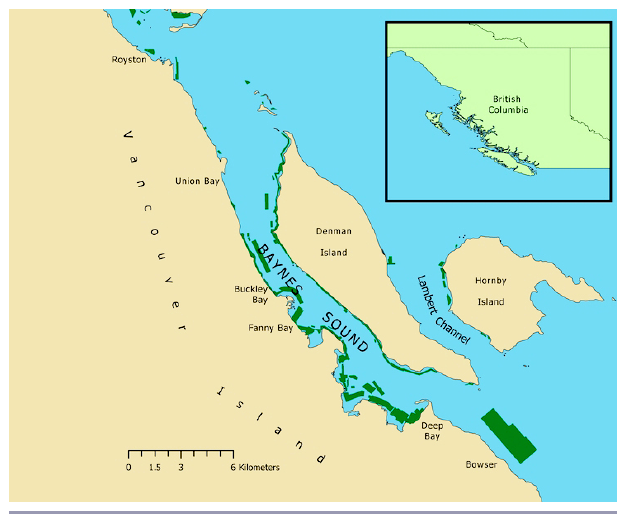
Fig. 1 . Map of the Baynes Sound area. The location and extent of shellfish farms are shown in